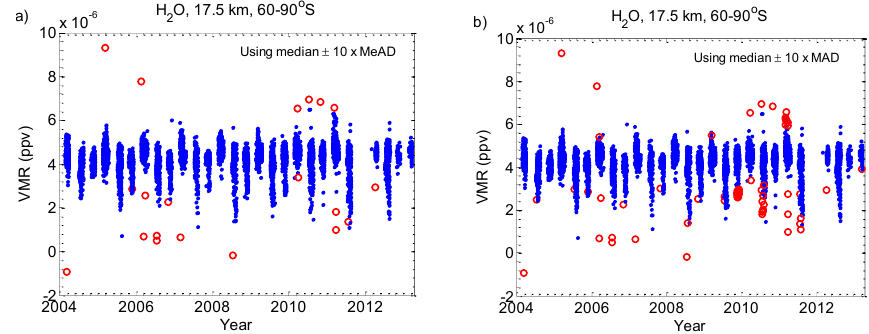
Figure 7. All Antarctic ACE-FTS data for H 2 O at 17.5km. The red circles are data that have been determined to be unnatural outliers following two different methods (sunrise and sunset data were analysed separately), and the blue dots are data that have been determined to be inliers. (a) Unnatural outliers determined using the 15day running MeAD. (b) Unnatural outliers determined using the 15day running MAD. Unnatural outliers as determined by the EDFs are not shown and were not used in the